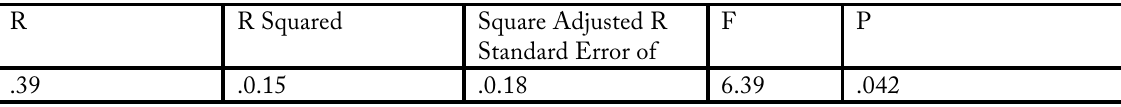
F P Standard Error of